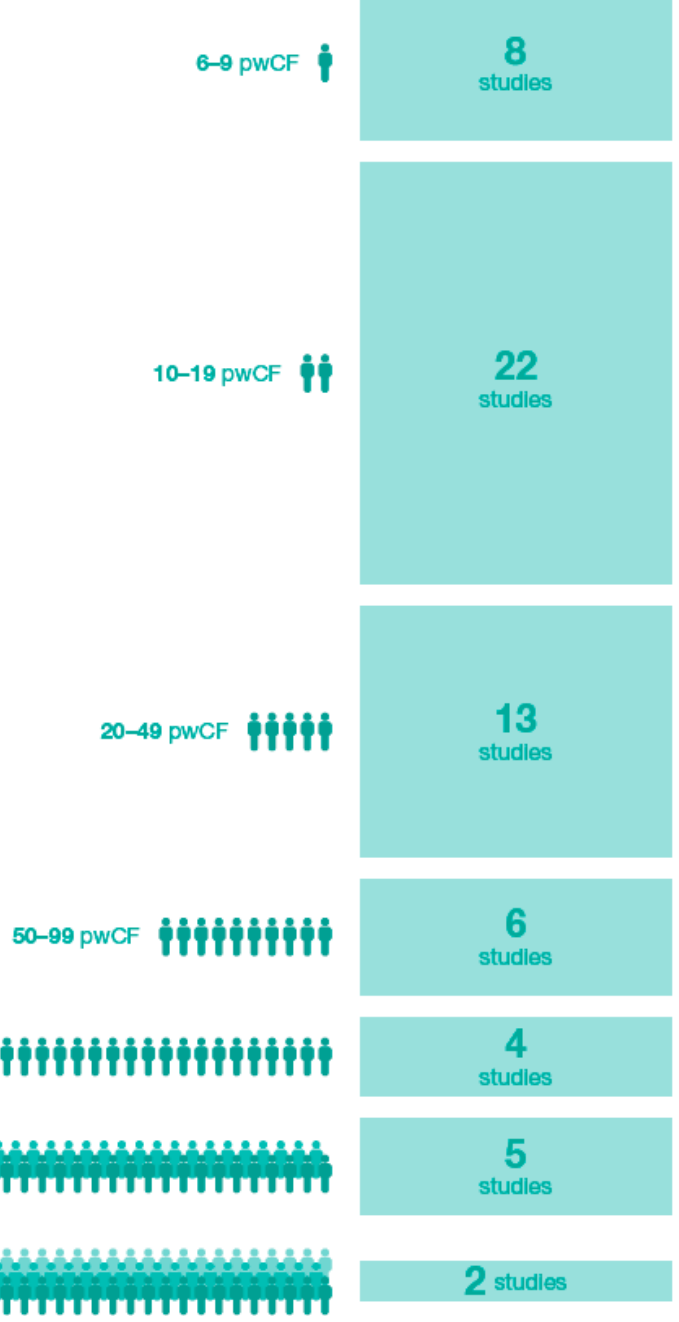
Figure 2. Real-world studies by ivacaftor-treated cohort size. Note: Studies do not sum to 57 because the Long-Term Safety Study reported results separately for US and UK cohorts treated with ivacaftor in cross-sectional [29] and disease progression analyses [30]. pwCF: people with cystic fibrosis.